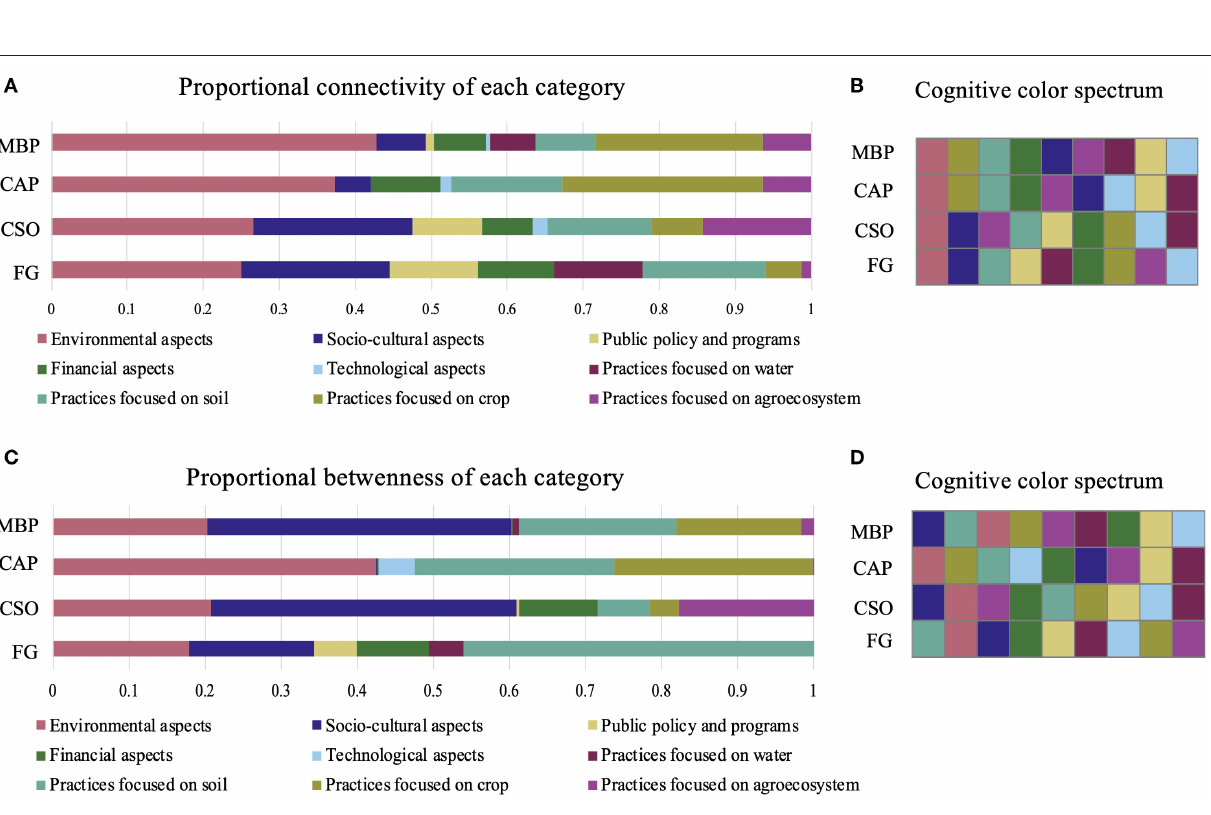
Frontiers in Sustainable Food Systems |